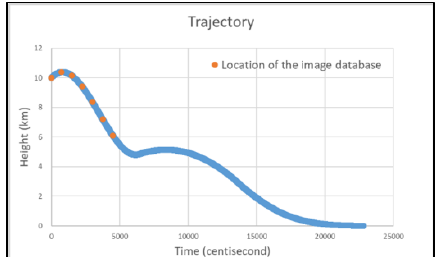
Figure 13. Height of the simulated reference trajectory